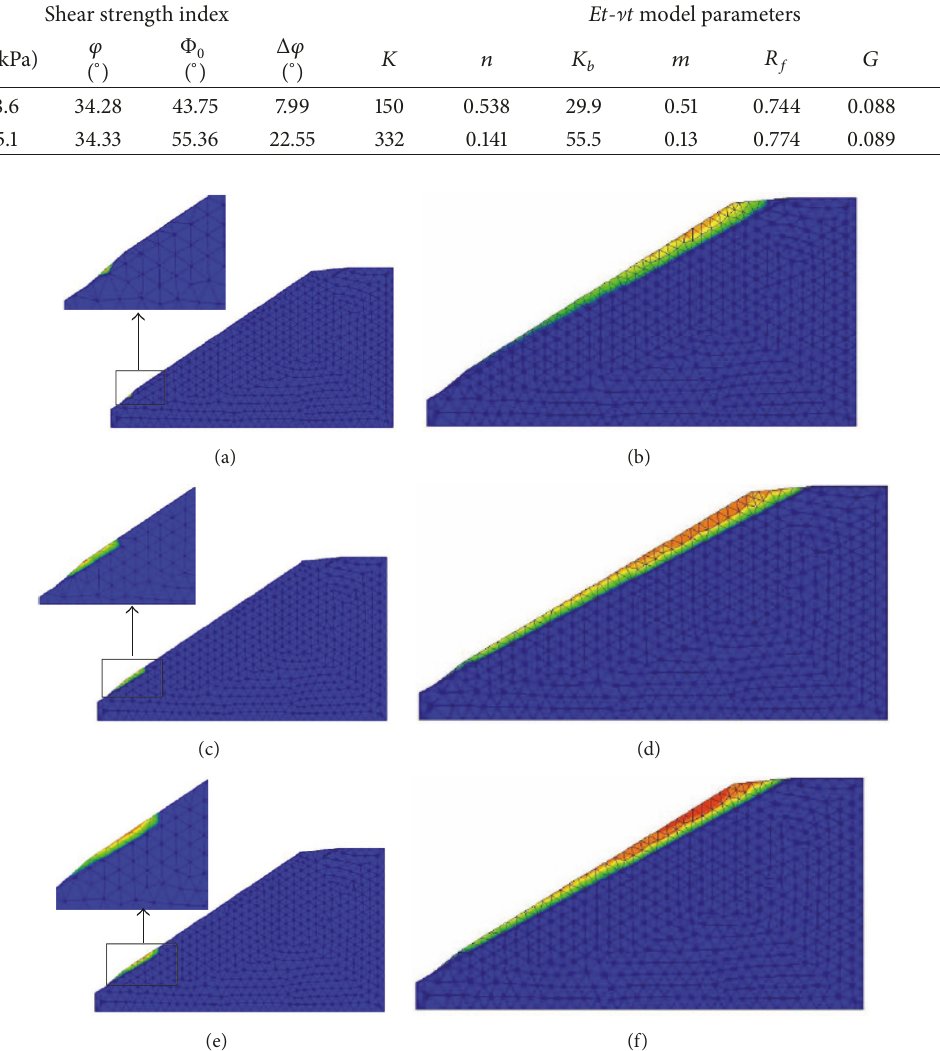
Figure 15: Maximum horizontal displacements of the deposited body: improved model after (a) 10,000, (c) 20,000, and (e) 30,000 time steps; unmodified model after (b) 10,000, (d) 20,000, and (f) 30,000 time steps.